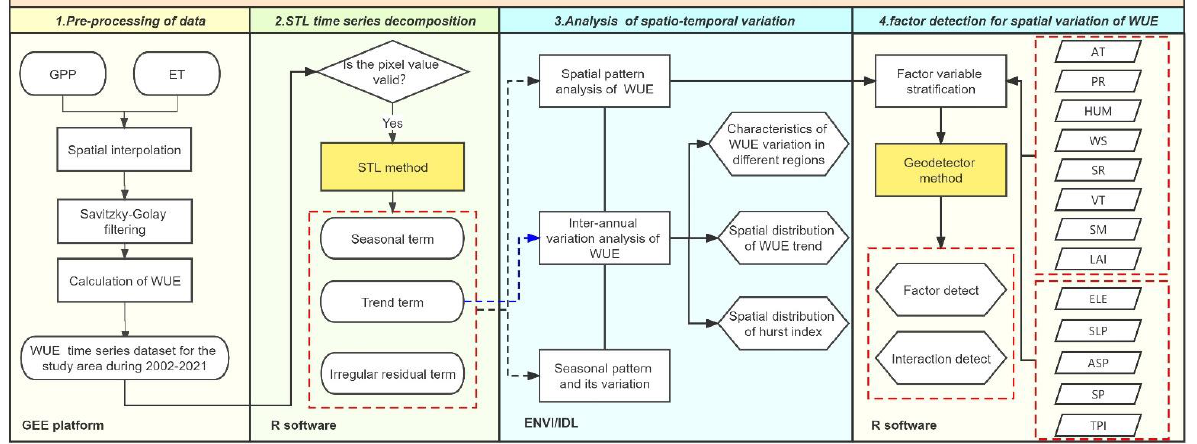
Figure 3. The overall technical scheme. AT: air temperature; PR: precipitation; HUM: specific hu- midity; WS: wind speed; SR: shortwave radiation; VT: vegetation type; SM: soil moisture; LAI: leaf area index; ELE: elevation; SLP: slope; ASP: aspect; SP: slope position; TPI: topographic position